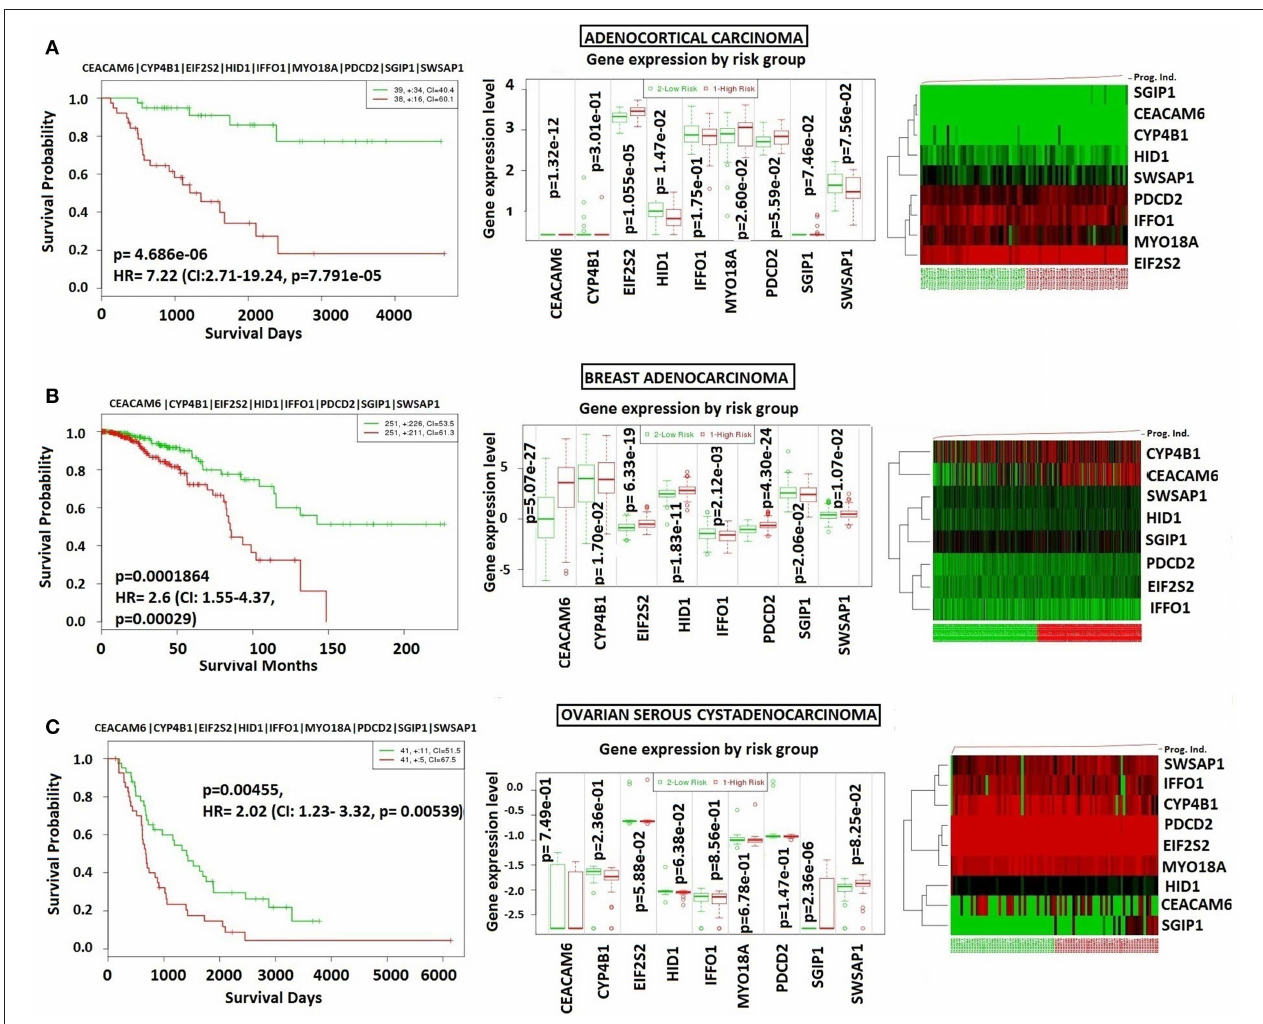
FIGURE 8 | Prognostic power of core module through related tissue type cancers. Core module was also prognostic for (A) Adrenocortical carcinoma, (B) breast adenocarcinoma, (C) ovarian serous